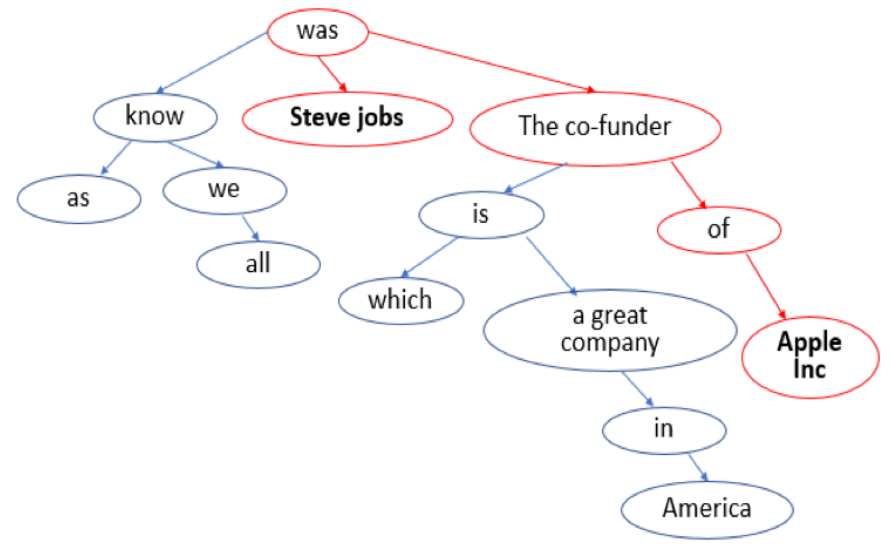
Figure 5. Dependency tree of the sentence “ As we all know, Steve Jobs was the co-founder of Apple Inc. which is a great company in America ”. Bold words are two candidate entities, red lines indicates the shortest dependency path between the two